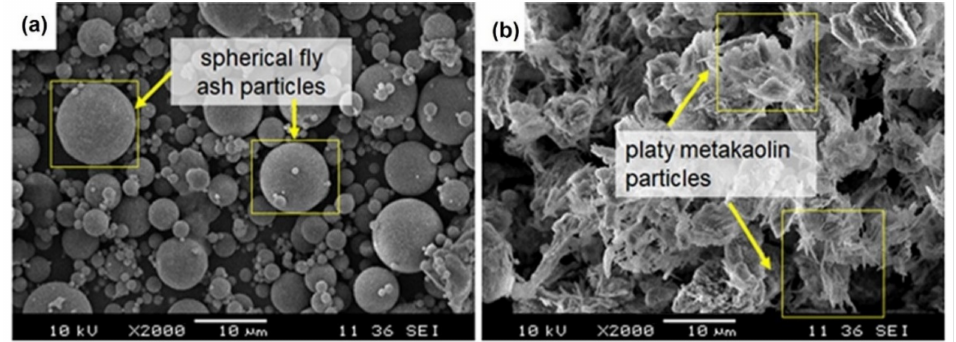
Figure 9. SEM images of ( a ) fly ash and ( b ) metakaolin. Reprinted with permission from Ref. [83]. Copyright 2021, with permission from